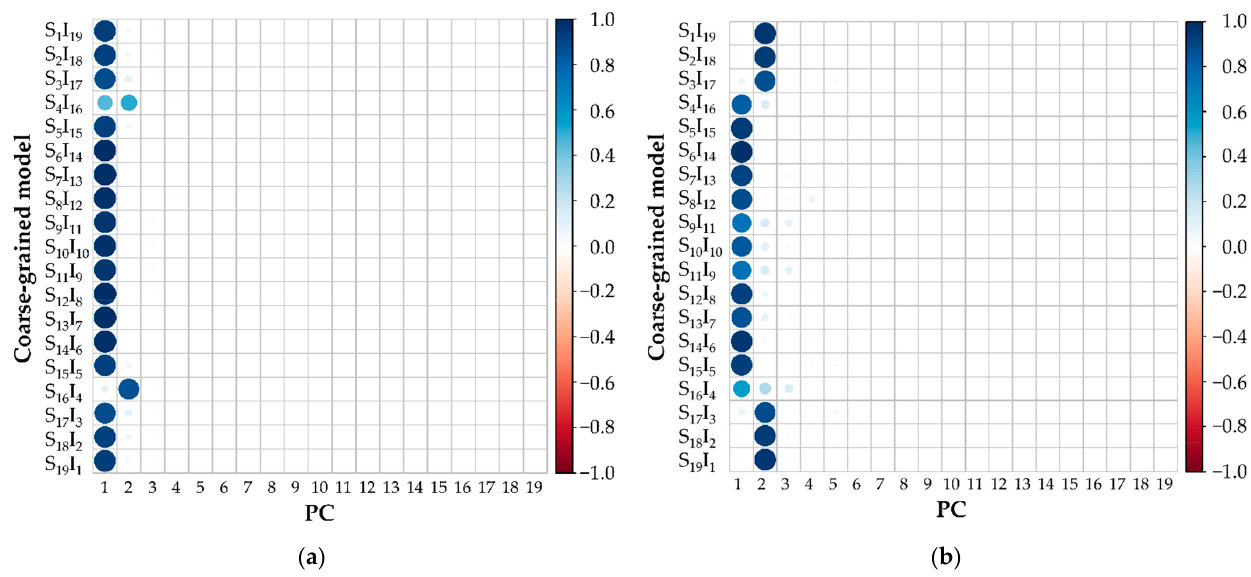
Figure 5. Correlation plots of ( a ) RDFs and ( b ) S( k ) show a relationship between the variables of coarse-grained models and each principal component (PC). The diameter of each circle indicates the contribution of each variable in each PC. The color shades indicate the quality of each variable in each PC and the range of the quality is represented as a color gradient at the right-hand side.